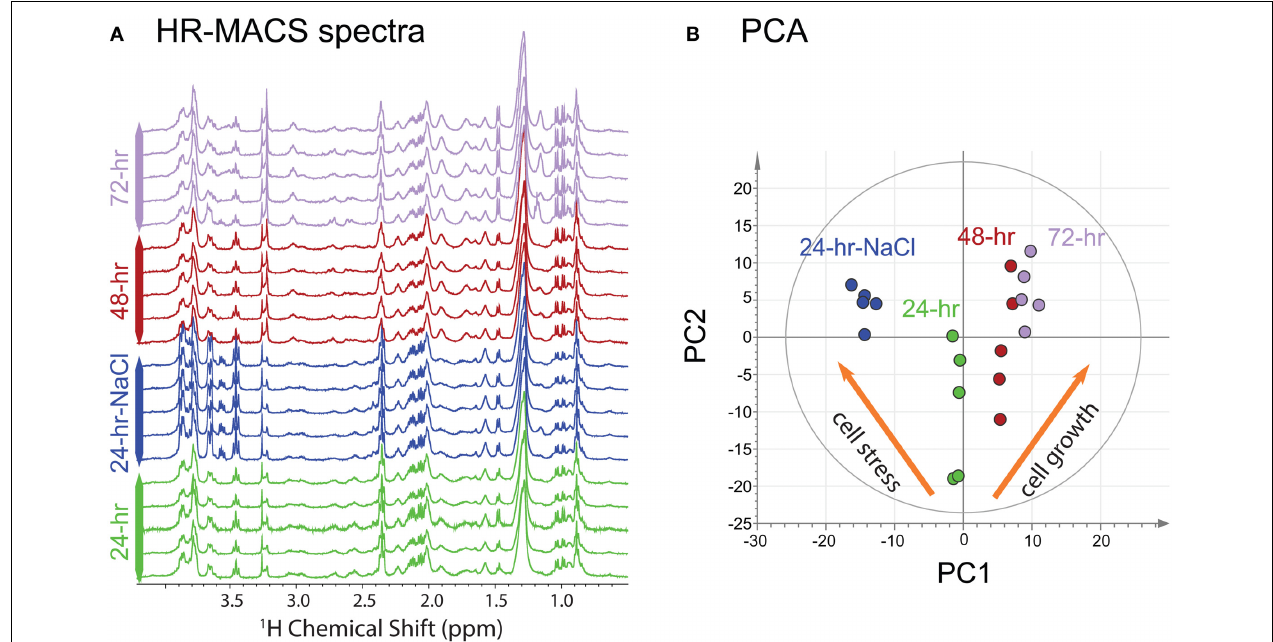
FIGURE 2 | (A) 1 H HR-MACS NMR spectra of the four different cell groups. (B) PCA score plot of all NMR datasets showing the quality of the sub-spectra [ R 2 X(cum) = 0.793; Q 2 (cum) = 0.737). The inserted orange narrows show the different metabolic patterns for the two studies.